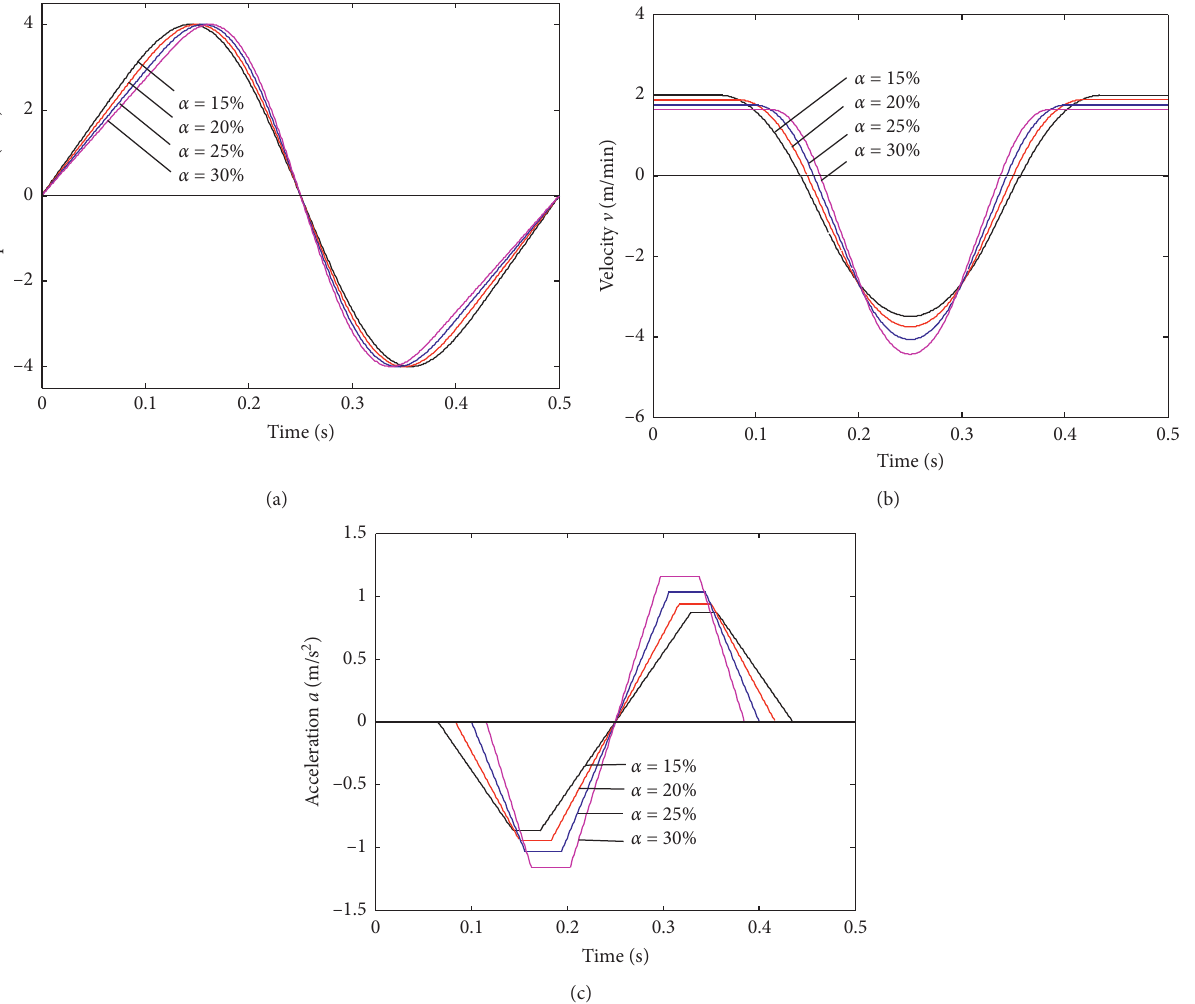
Figure 2: Nonsinusoidal oscillation waveform of seven section functions. (a) Displacement curves. (b) Velocity curves. (c) Acceleration